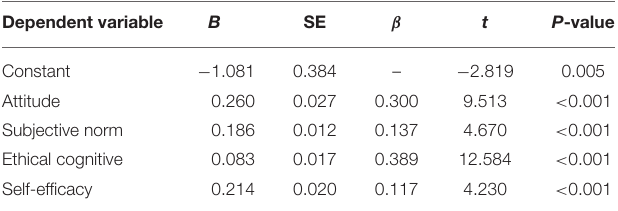
TABLE 5 | Factors influencing respondents’ behavioral intentions to care for COVID-19